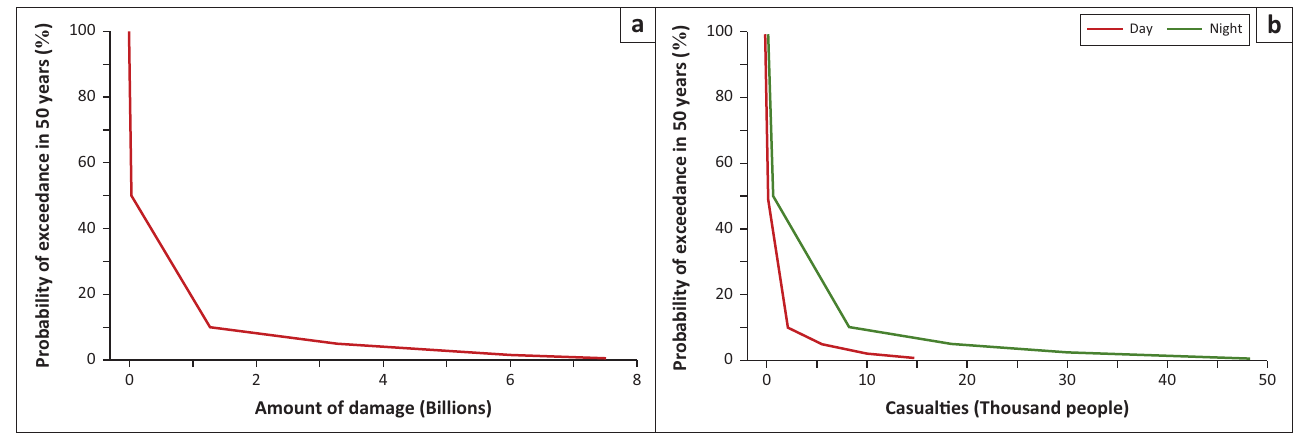
FIGURE 6: Calculation of risk in terms of (a) economic loss and (b) casualties for all residential building in Bantul region.